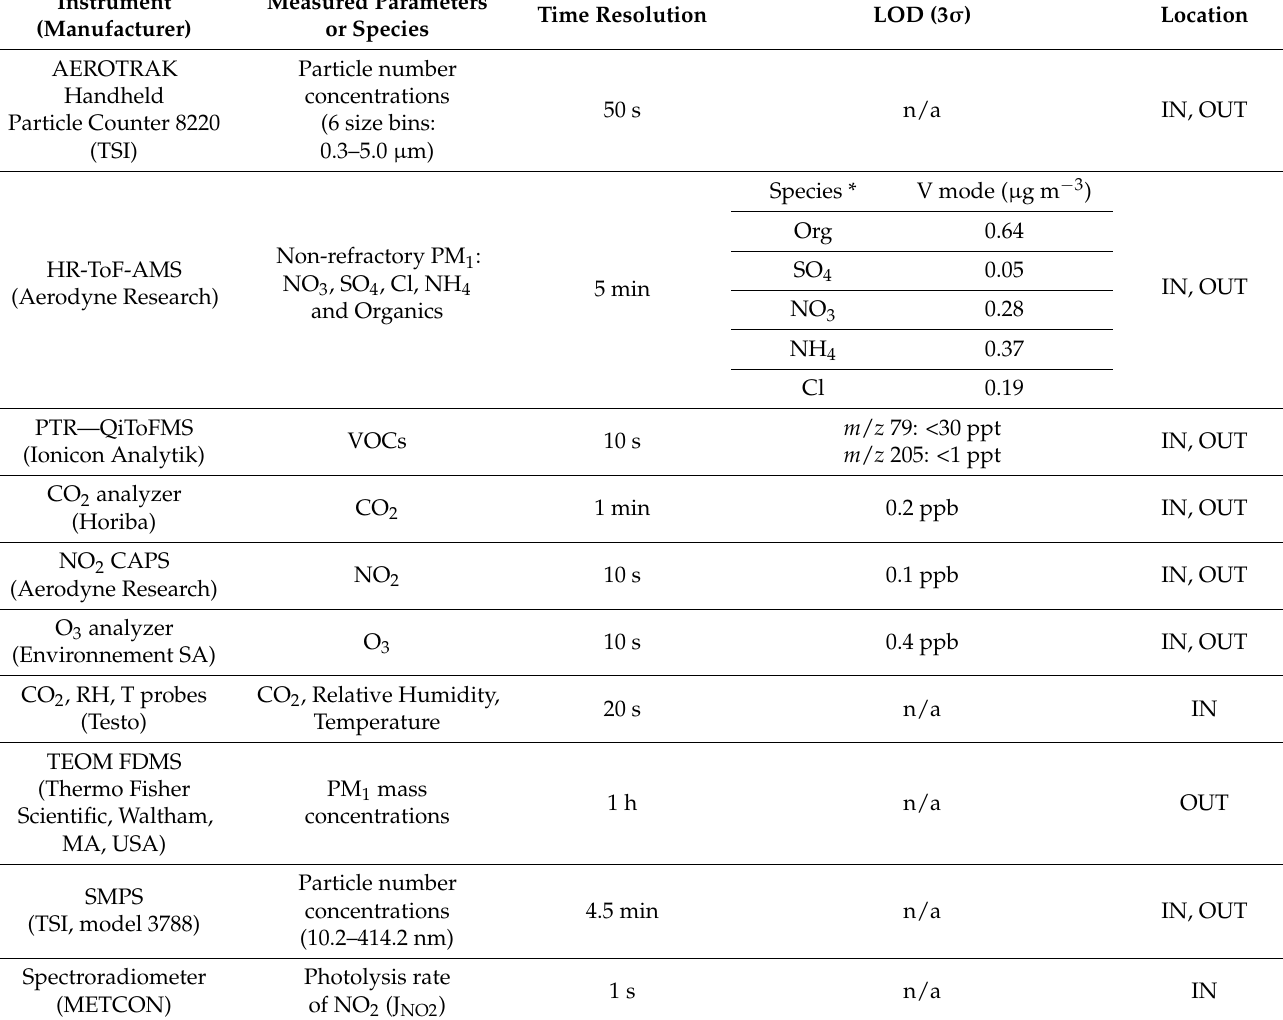
Table 1. Summary of instrumentation, time resolution and limit of detection